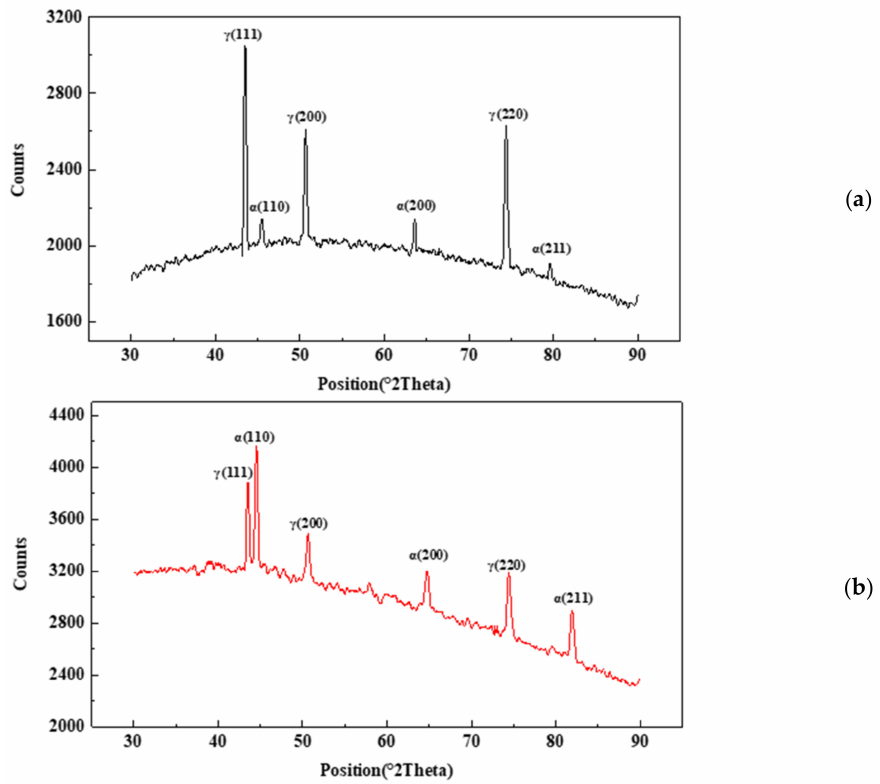
Figure 17. XRD analysis results of samples without and with corrosion inhibitor (( a ) 180 ◦ C without inhibitor, ( b ) 180 ◦ C with